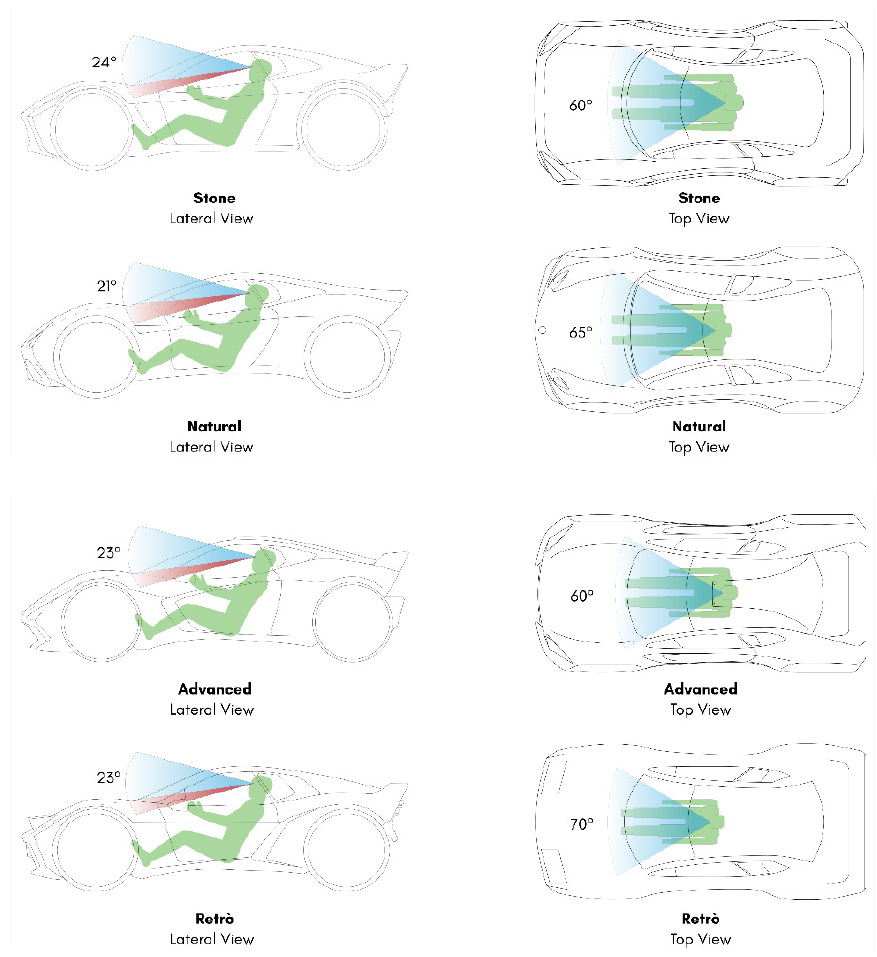
Figure 19. Simulation and measuring of visibility angles for each concept.